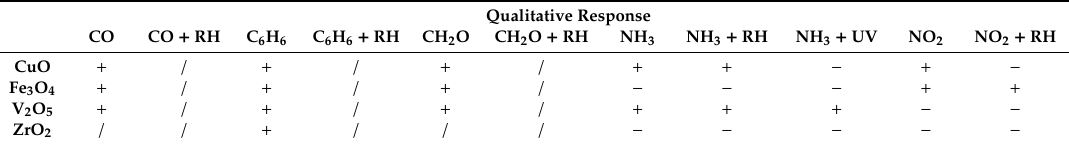
Table 3. Summary of response directions ( + for positive, − for negative, and / for no response) of all sensors towards CO, C 6 H 6 , CH 2 O, NH 3 , and NO 2 under dry and humid conditions.